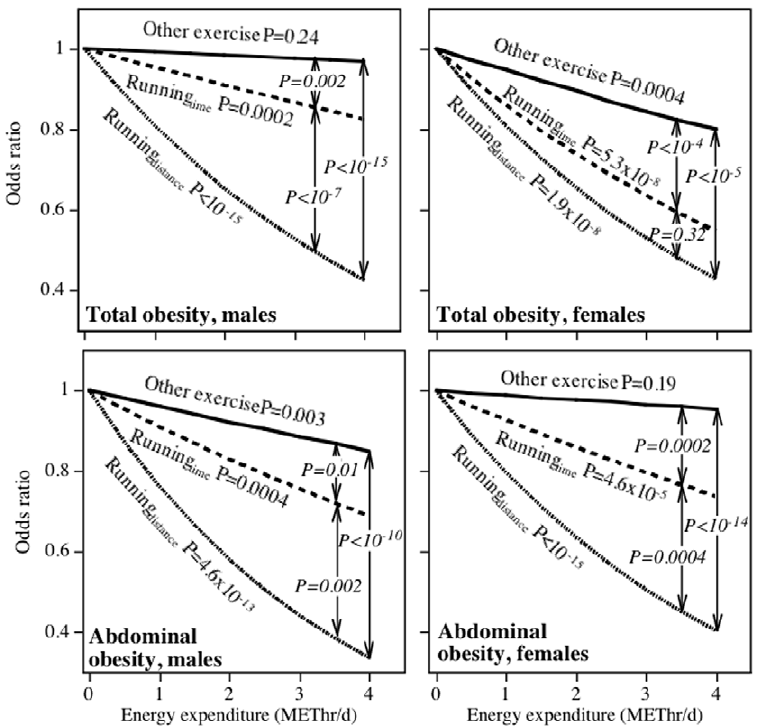
Figure 2. Odds reduction in obesity (BMI $ 30 kg/m 2 ), and abdominal obesity per METhr/d energy expenditure. Significance levels presented for a = b , a = c and b = c in the model: ln(p/(1-p))=intercept + a Running Distance + b Running Time + c Other exercise + covariates.